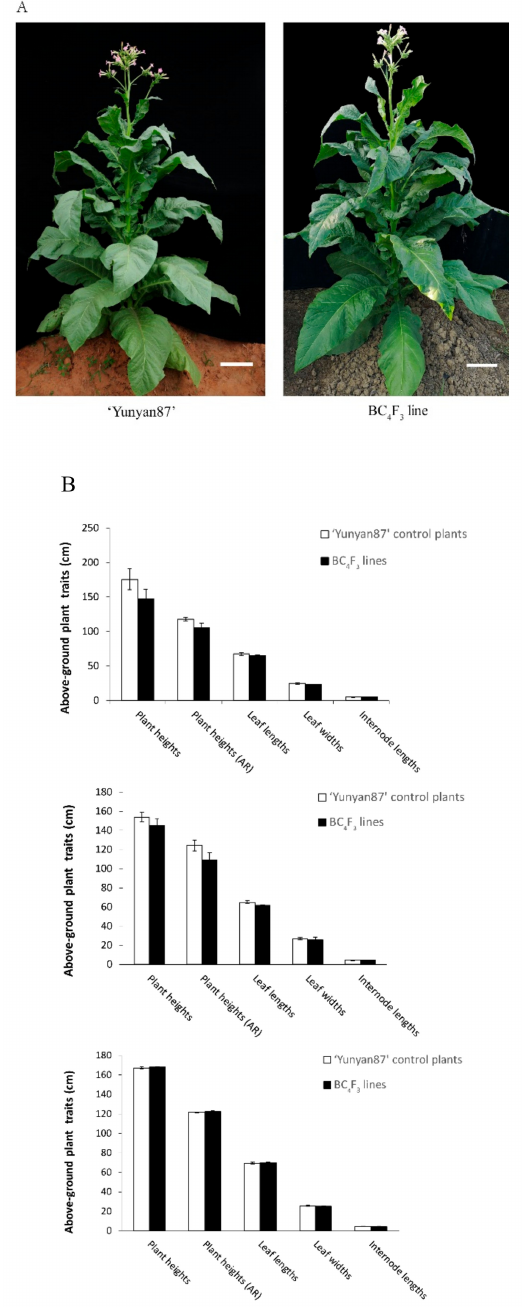
Figure 4. Phenotypes of ‘Yunyan87’ control plant and BC 4 F 3 line. ( A ) Flowering stages of ‘Yunyan87’ control plant (left) and BC 4 F 3 line (right). Bars = 100 mm. ( B ) Comparison of the above-ground plant traits between ‘Yunyan87’ control plants and BC 4 F 3 lines at Baoshan (top), Chuxiong (middle), and Qujing (bottom) in the Yunnan province. Plant heights (AR): the plant heights after removal of the shoot apex. Error bars represent standard deviations (SD). Data are shown as mean ± SD (n = 3). Statistical analyses were performed using the paired Student’s t